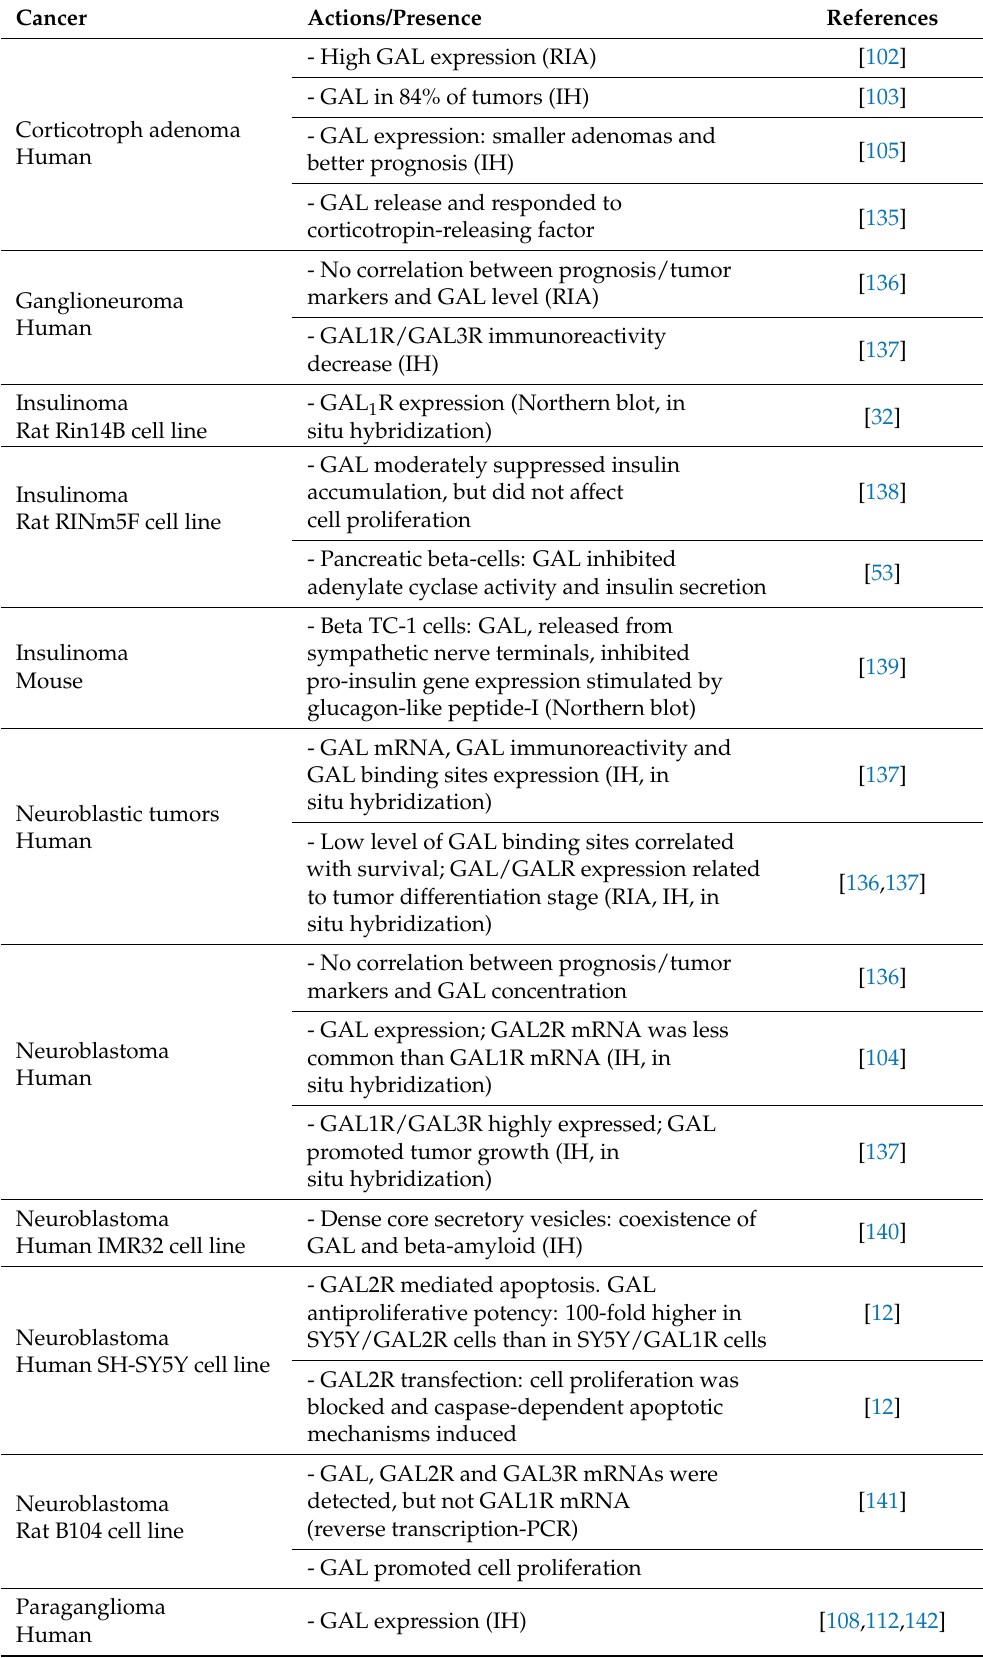
Table 1. Involvement of the galaninergic system in neuroendocrine